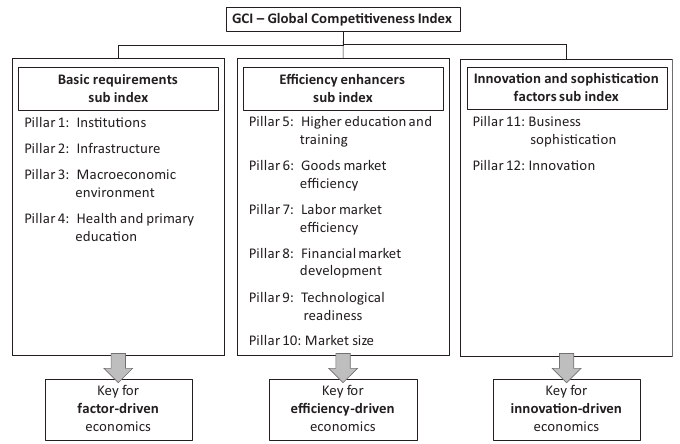
Figure 1. Pillars of GCI